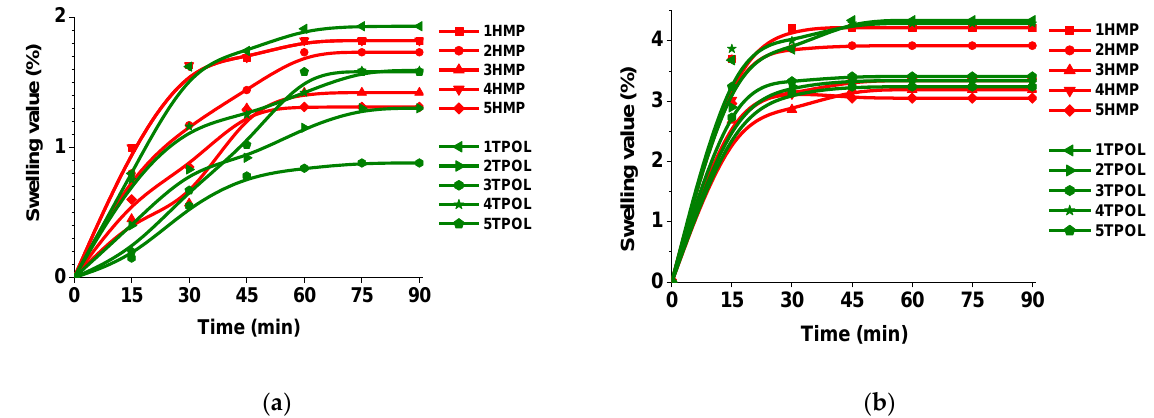
Figure 4. ( a ) Swelling value versus time curves of the polymers in acetone, ( b ) Swelling value versus time curves of the polymers in toluene.